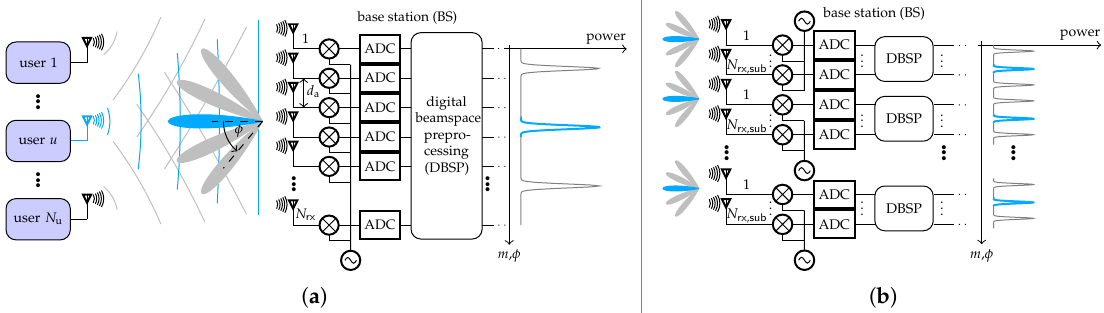
Figure 1. Digital beamspace preprocessing in noncoherent massive multiple-input/multiple-output (MIMO) systems: ( a ) Full-array and ( b ) sub-array